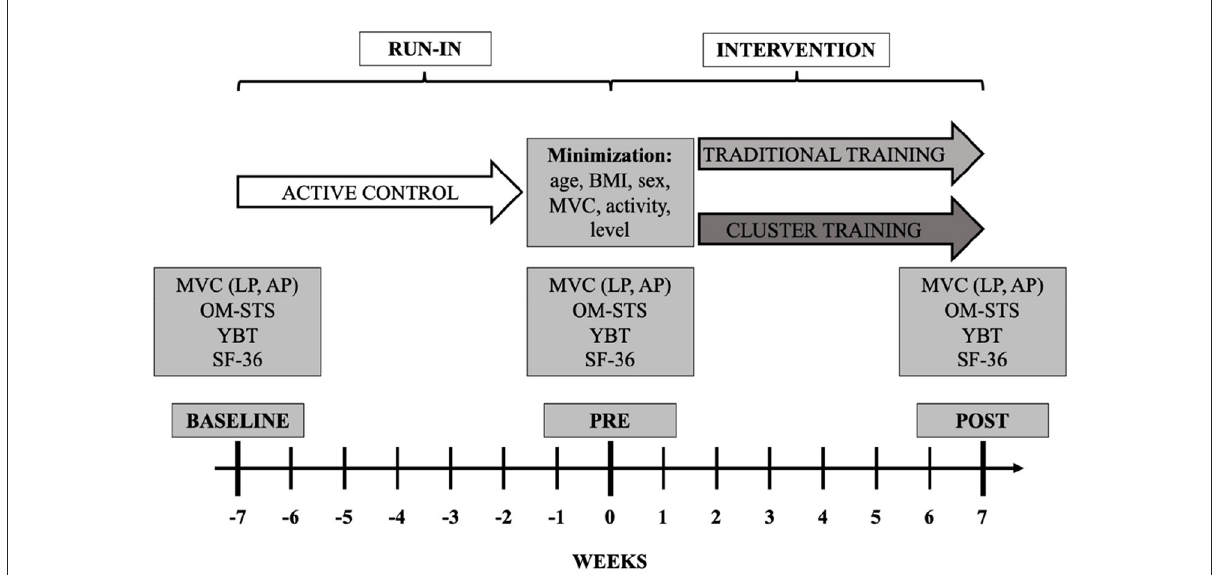
FIGURE1 Schematic representation of the experimental protocol. Testing at BASELINE, PRE, and POST consisted of maximal isometric voluntary contraction (MVC) at leg press (LP) and abdominal press (AP), one-minute sit-to-stand (OM-STS), Y-Balance-test (YBT), and quality-of-life-questionnaire (SF-36). After PRE, group assignment was performed by employing the minimization method using age, body mass index (BMI), sex, maximal voluntary contraction of abdominal press and leg press in N (MVC), mean physical activity in minutes (activity), and exercise level (level) as